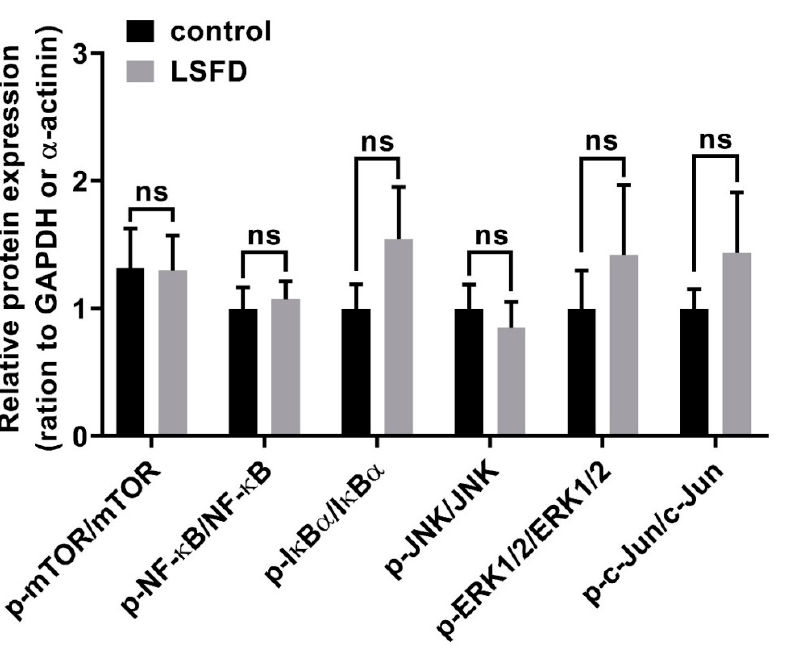
Figure 6. Western blot analysis data showing the relative protein expression in the wound bed at day 10 post-wounding in the control group and β -sheet LSFD-treated group. GAPDH, glyceraldehyde 3-phosphate dehydrogenase I κ B α , nuclear factor of kappa light polypeptide gene enhancer in B-cells inhibitor, alpha; JNK, c-Jun N-terminal kinase; mTOR, mechanistic target of rapamycin; NF- κ B, nuclear factor kappa B; p indicates the phosphorylated protein. Data are presented as the mean ± standard error of the mean ( n = 7; ns: not significant).